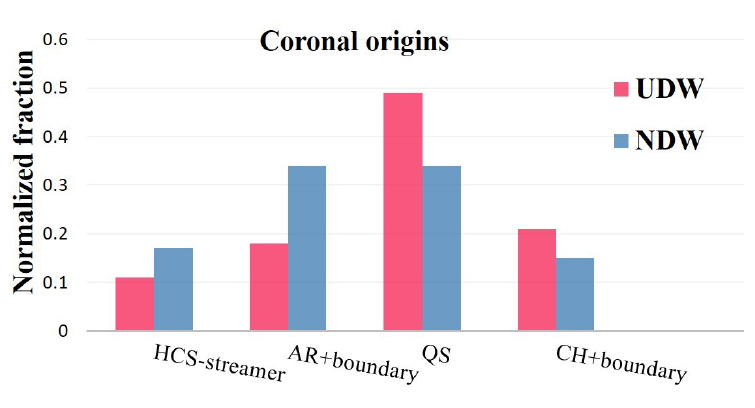
Figure 7. Fractional distributions of the UDW (NDW) according to the four combined coronal regions: HCS-streamer, active regions and their boundary , quiet Sun, and coronal holes and their boundary, shown in magenta